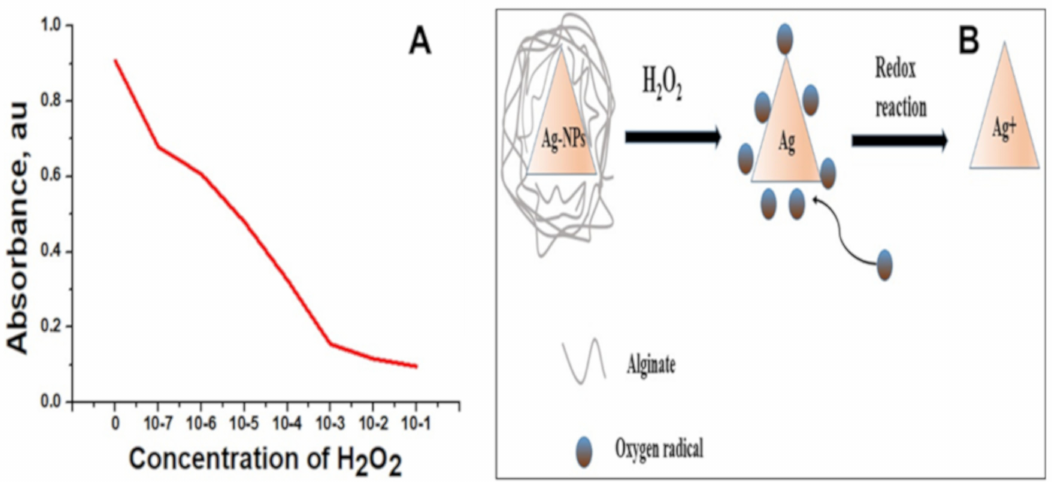
Figure 7. ( A ) Change in absorbance versus H 2 O 2 concentration. ( B ) Possible mechanism of the reaction between the Ag-NPs and H 2 O 2